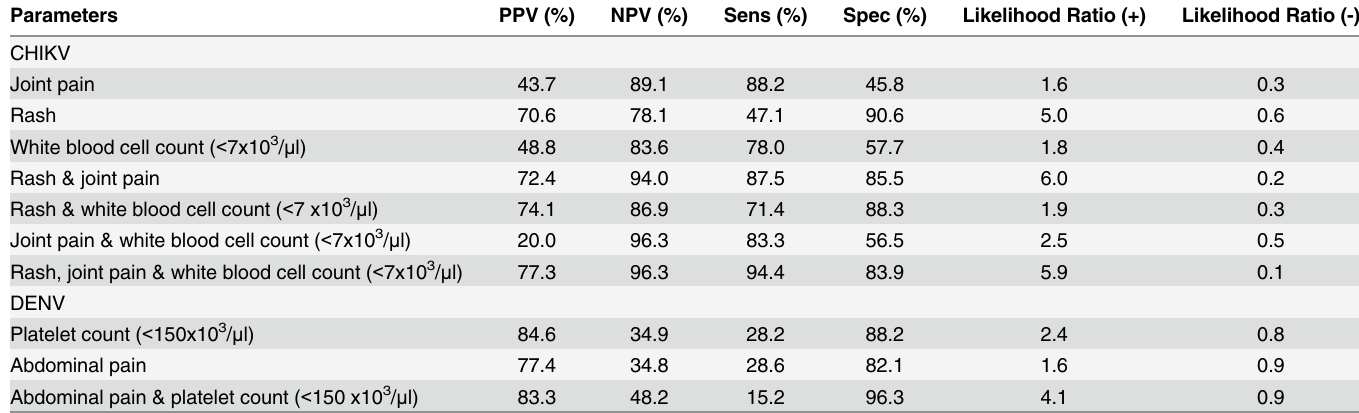
Table 4. Positive predictive values (PPVs), negative predictive values (NPVs), sensitivity, specificity and likelihood ratios of clinical features used to distinguish patients of the APCF of the EWMSC, T&T (Dec 2013 – Nov 2014) with DF l= and CHIKF l= from patients with other AUFIs. Parameters